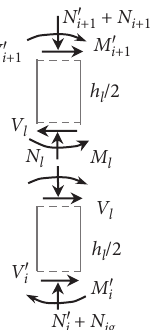
Figure 1: Sketch of deformation of investigated lump i